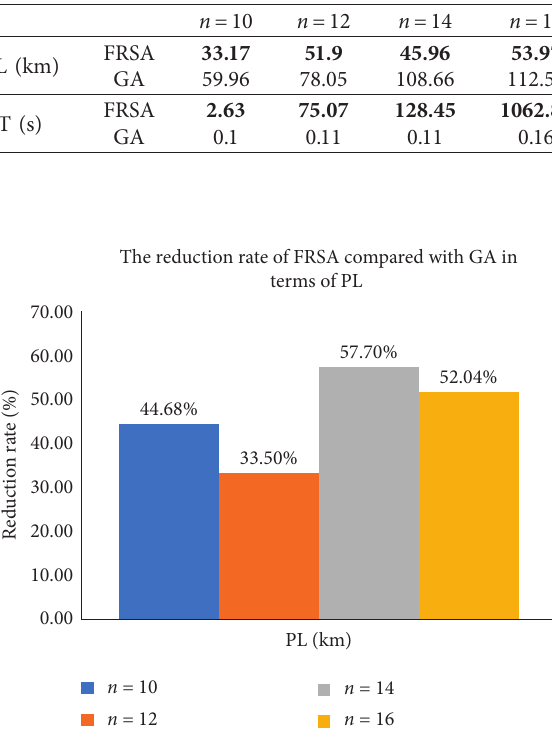
Figure 6: The reduction rate of the optimal paths offered by FRSA compared with GA in terms of